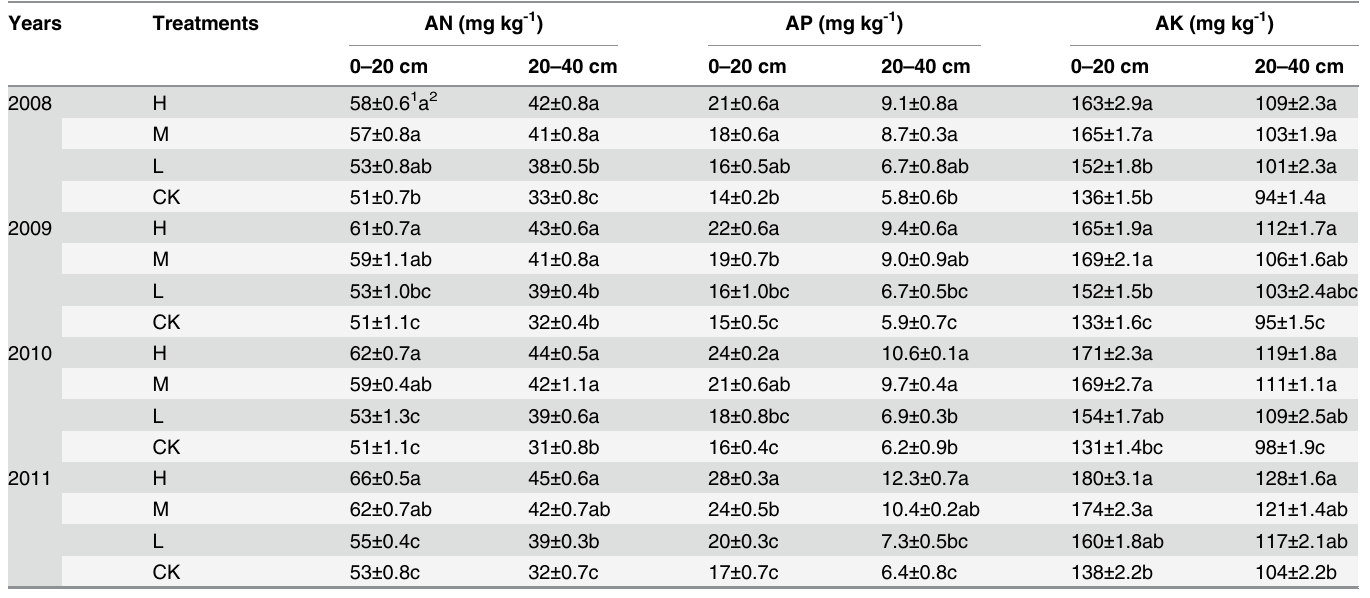
Table 3. Soil available nutrients content under different wheat straw incorporation treatments in 0 – 20 and 20 – 40 cm soil layers from 2008 to 2011. Years